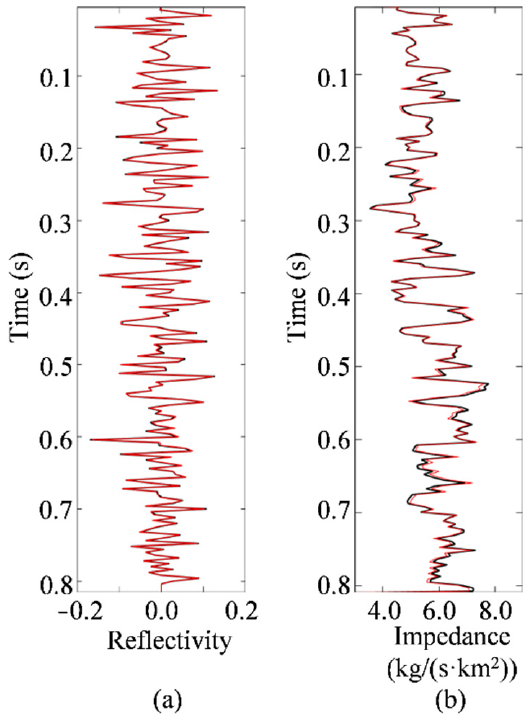
Figure 6. The inverted reflectivity series and impedances from ENRI performed on the noise-contaminated trace with SNR = 4. ( a ) Reflectivity series; ( b ) impedance.